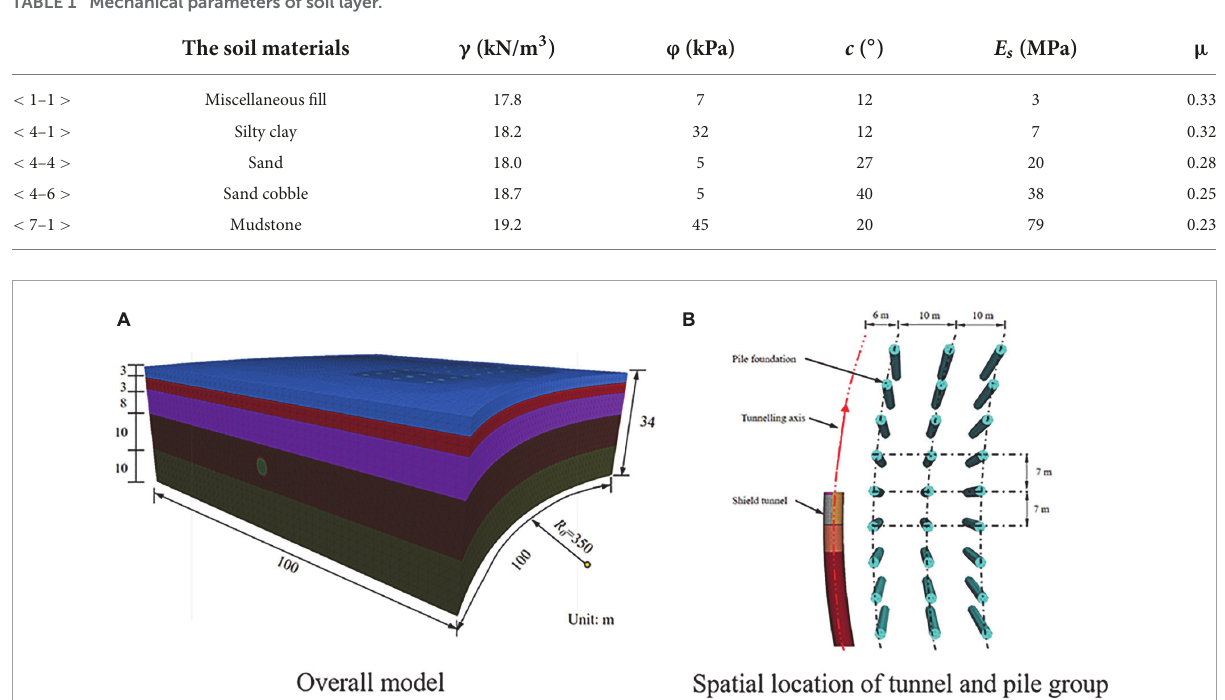
FIGURE4 Model diagram. (A) Overall model and (B) spatial location of tunnel and pile group.